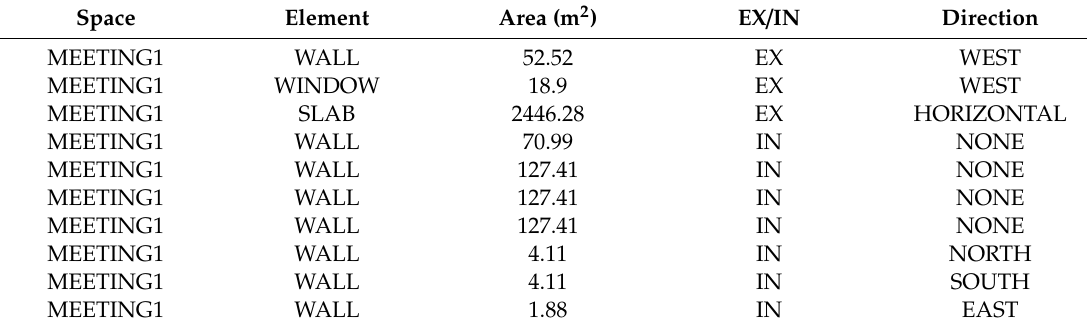
Table 4. Database form example (model 2, subject B, automation).